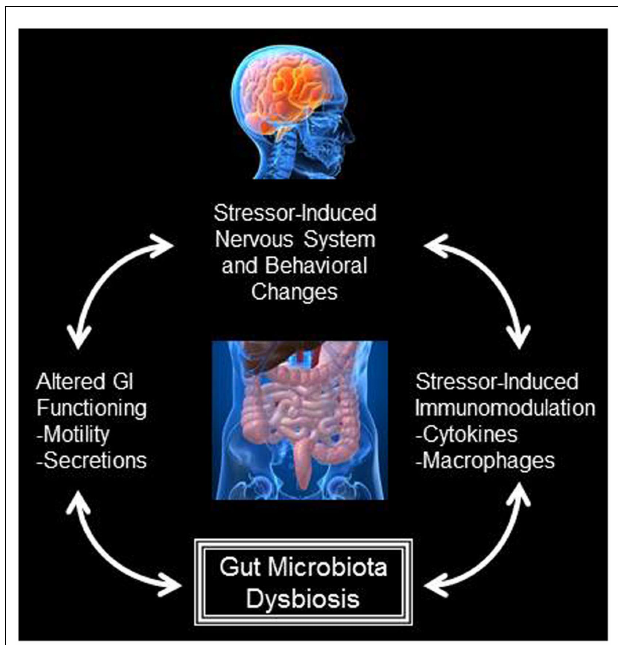
FIGURE 1 | Bidirectional interactions exist between the central nervous system and the gut microbiota . During exposure to stressful stimuli, the physiological stress response can lead to alterations in gastrointestinal functioning, such as alterations to gastrointestinal motility and the secretion of factors like gastric acid and bile.The physiological stress response is also known to impact immune system activity. Both alterations to gastrointestinal functioning and immune system activity can significantly change the composition of the gut microbiota.These alterations to the microbiota can feedback and impact gastrointestinal functioning, immune system activity, as well as the physiological stress response and stressor-induced behavioral